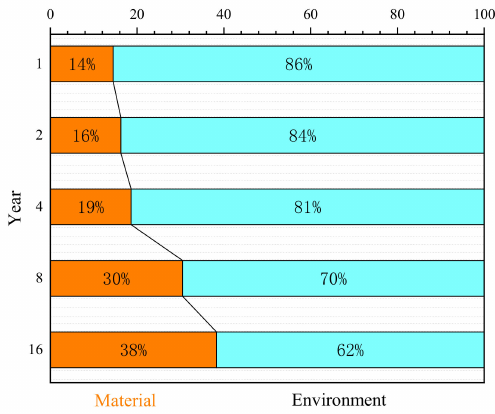
Figure 8. The percentage variations of the contribution variations of the material and environment vs. exposure time.